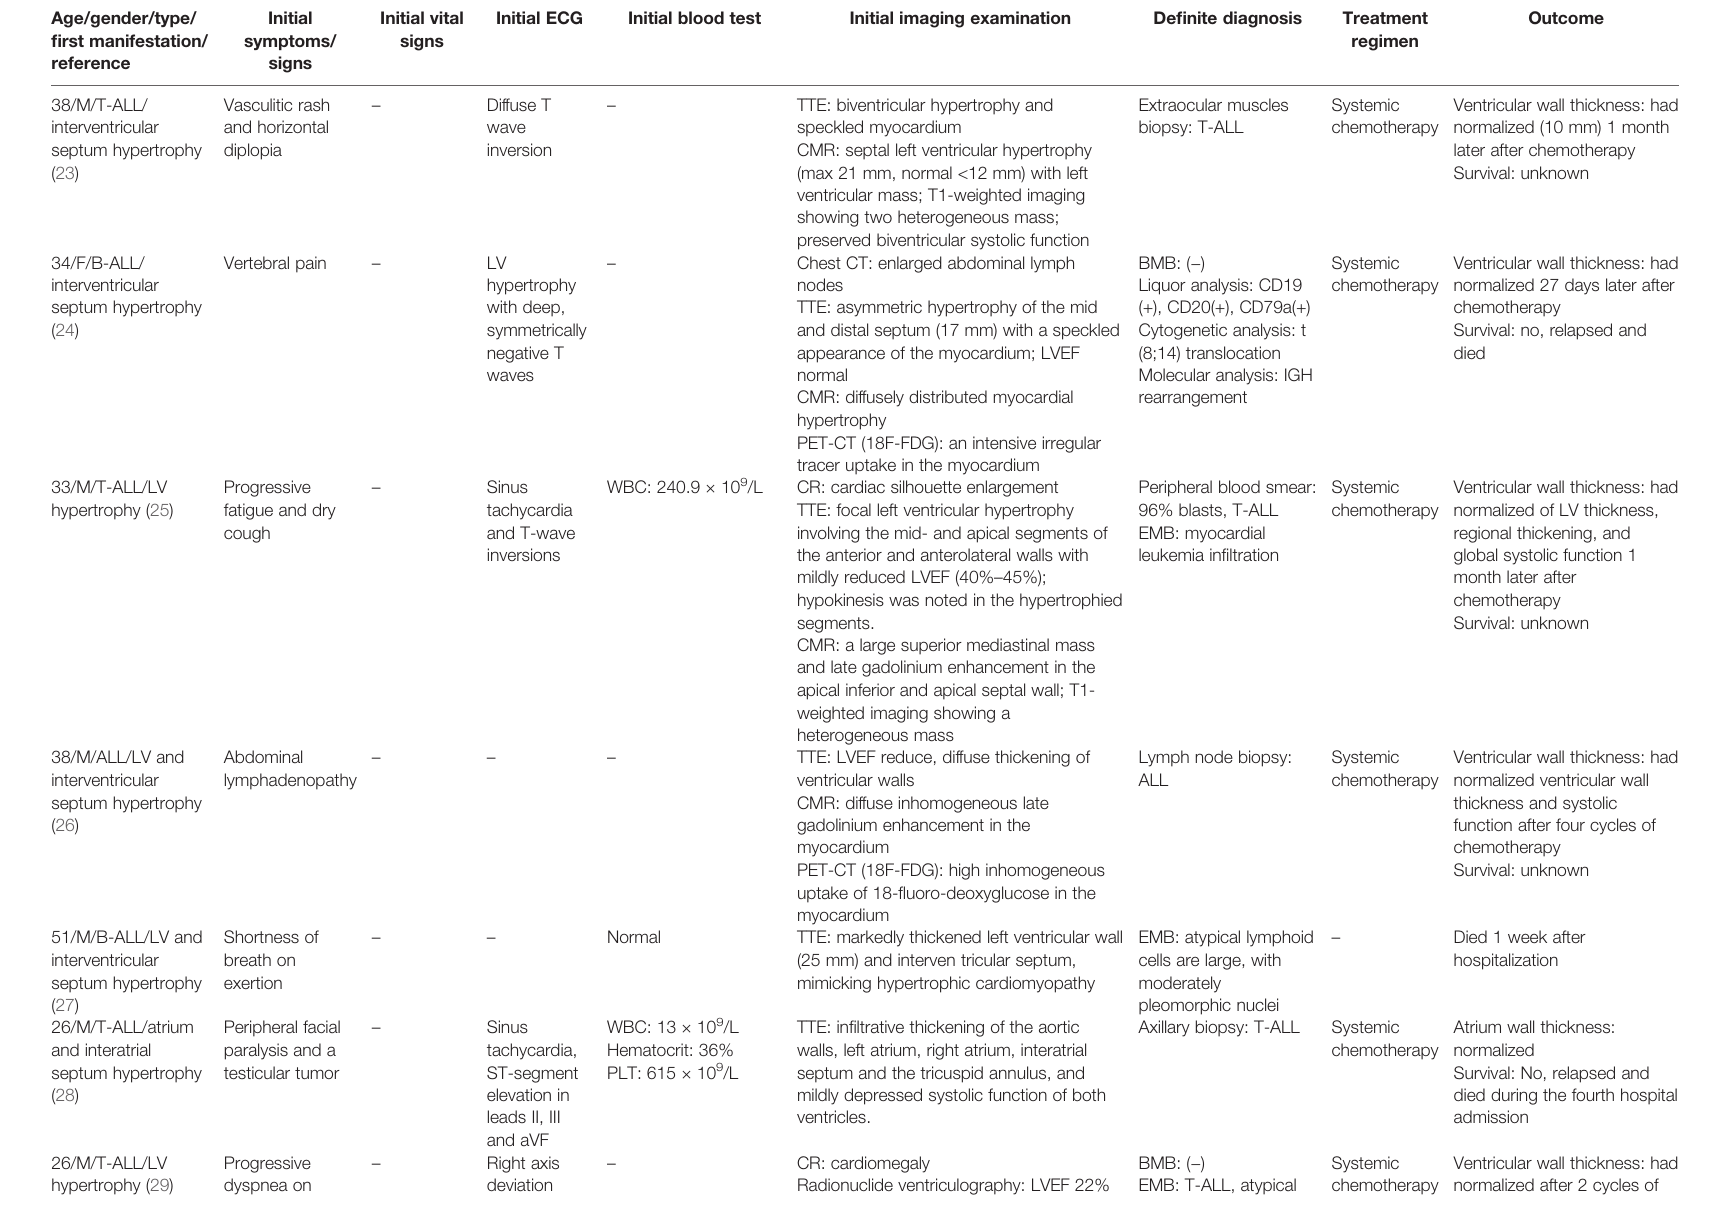
TABLE 3 | Myocardium hypertrophy as fi rst manifestation of acute lymphoblastic leukemia. Age/gender/type/ fi rst manifestation/